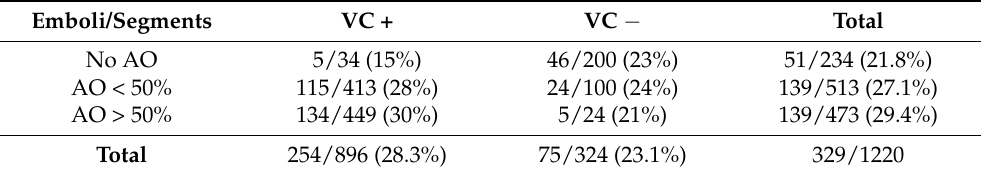
Figure 4. Intrasegment association of VC and PE. Out of 329 total segmental or subsegmental emboli, 77% (95% CI, 75–80%) were associated with VC in the same lung segment. Furthermore, out of 58 occlusive segmental or subsegmental emboli, 84% (95% CI, 80–89%) were associated with VC in the same lung segment. Table 3. Rate of segmental and subsegmental PE in segments with and without concomitant VC, stratified by AO severity (n = 329 segmental emboli in 1200 pulmonary segments).